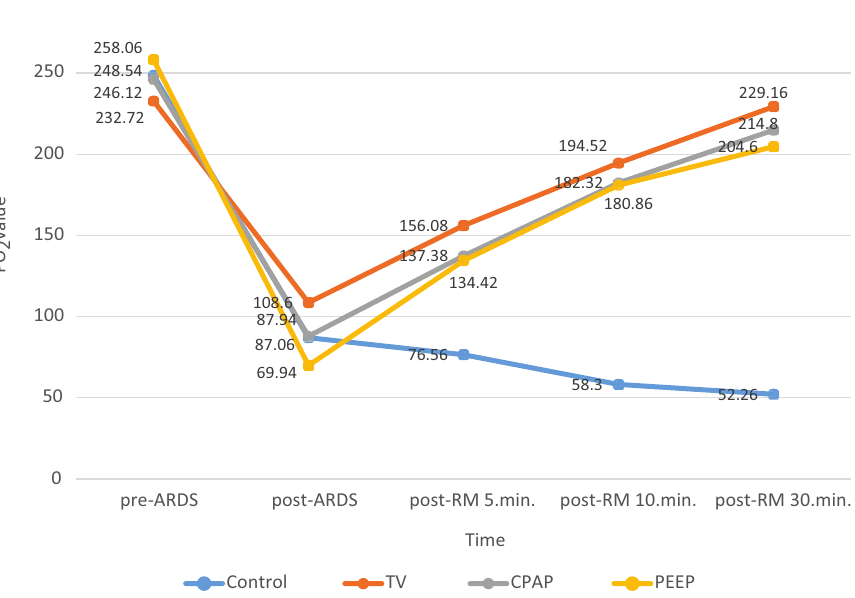
Figure 1. Change of the PaO values. PaO , partial arterial oxygen pressure; ARDS, acute respiratory 2 2 distress syndrome; TV, tidal volume; CPAP, continuous positive airway pressure; PEEP, positive end- expiratory pressure; RM, recruitment